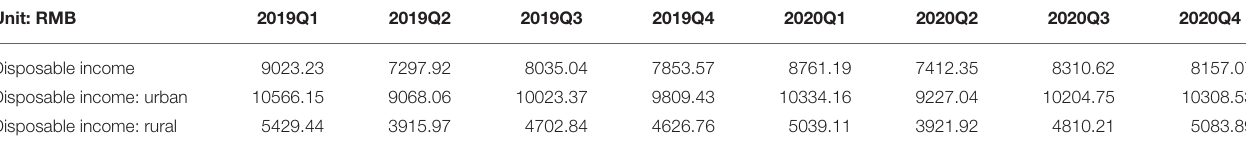
TABLE 3 | Disposable income per capita by quarter in 2019 and 2020. Unit: